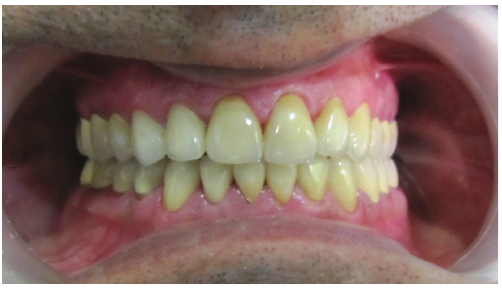
Figure 8: Definitive